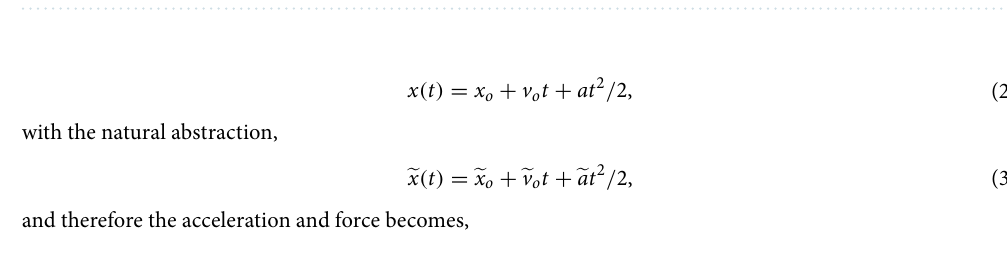
Figure 4. Abstraction of the acceleration and force with reflection to Galileo’s experiment of 1591 24,25